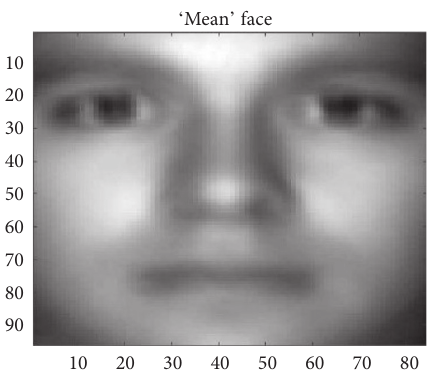
Figure 3: Mean face the YaleB